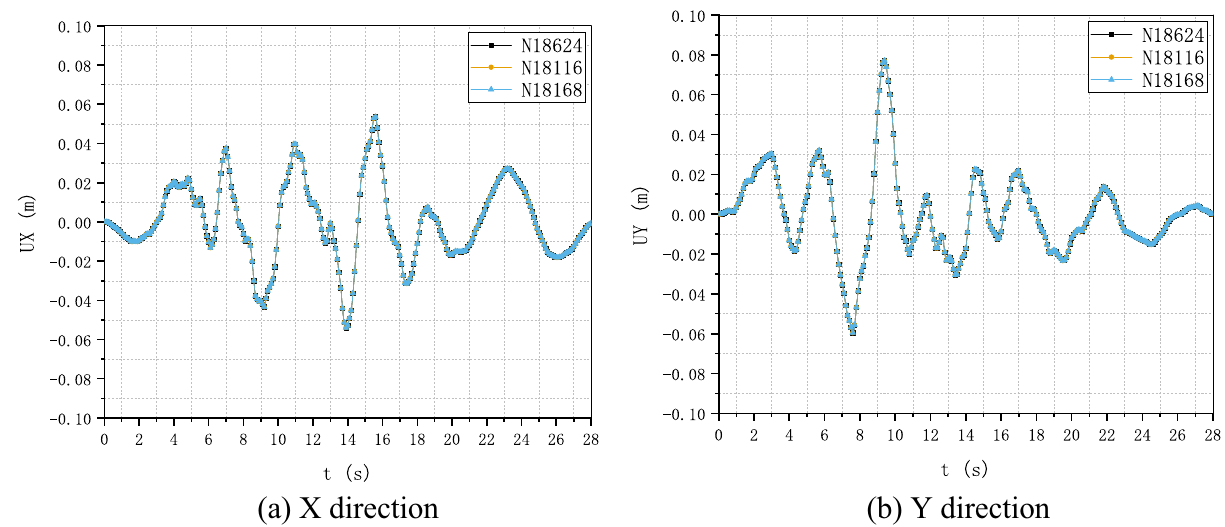
Figure 24. Horizontal displacement histories of monitoring points at the foundation. ( a ) X direction, ( b ) Y direction.